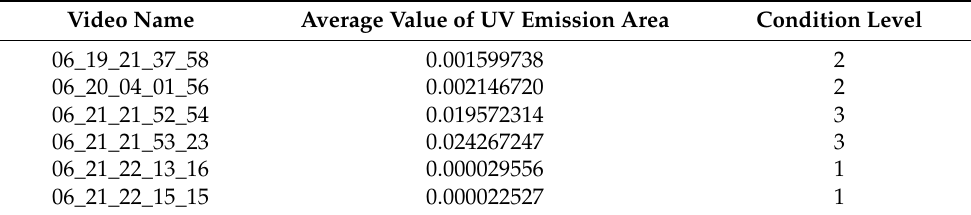
Table 6. UV quantitative parameter and visual-based assessment results in representing the insulator string condition in the GT and GIS